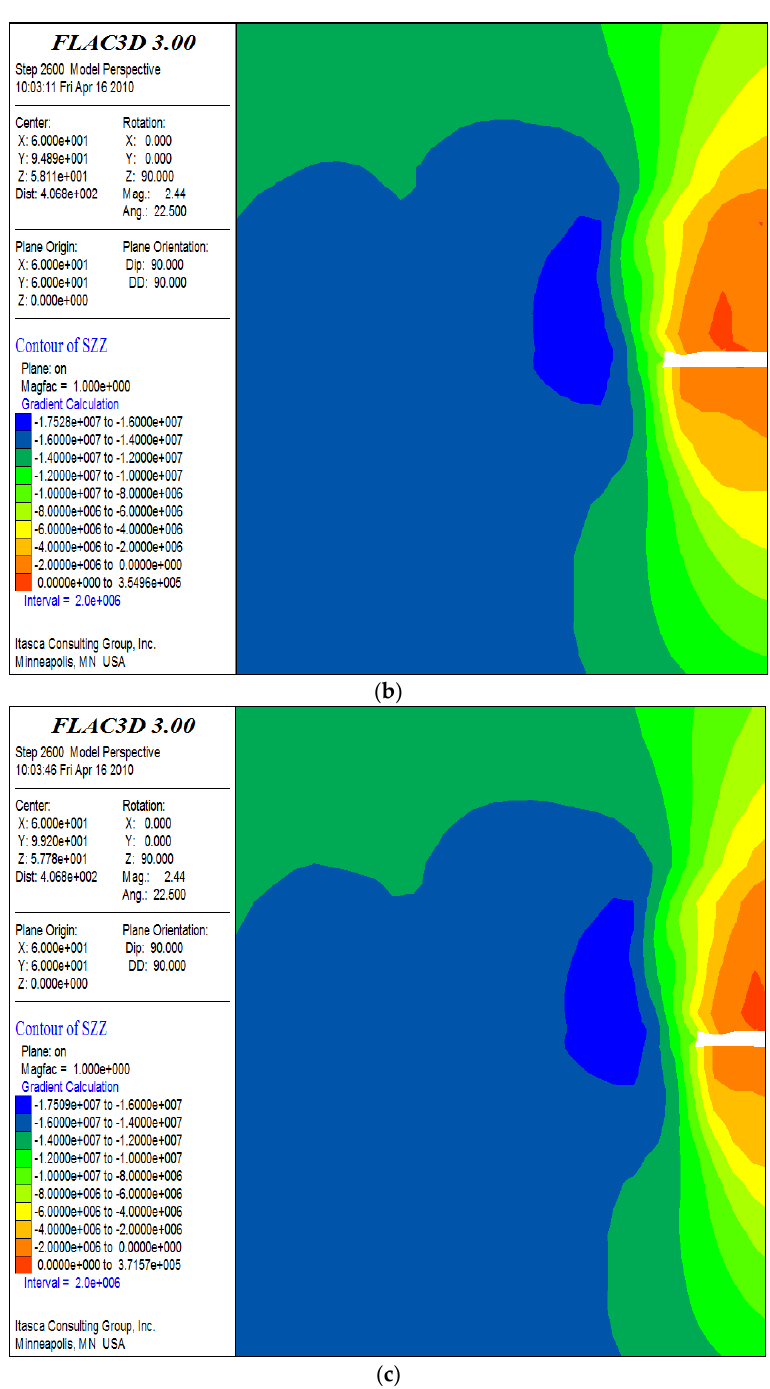
Figure 13. Simulation of stress distribution under three different borehole interval conditions: ( a ) 10 m; ( b ) 15 m; ( c ) 20 m.